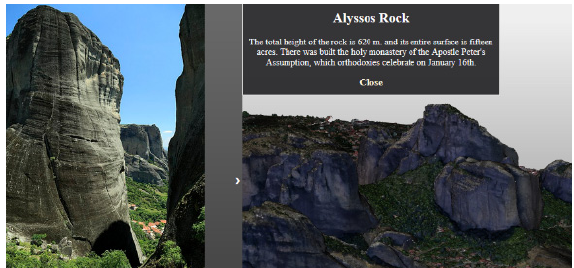
Figure 8. Screenshot from the display of text and image data for Alyssos rock via the METEORA